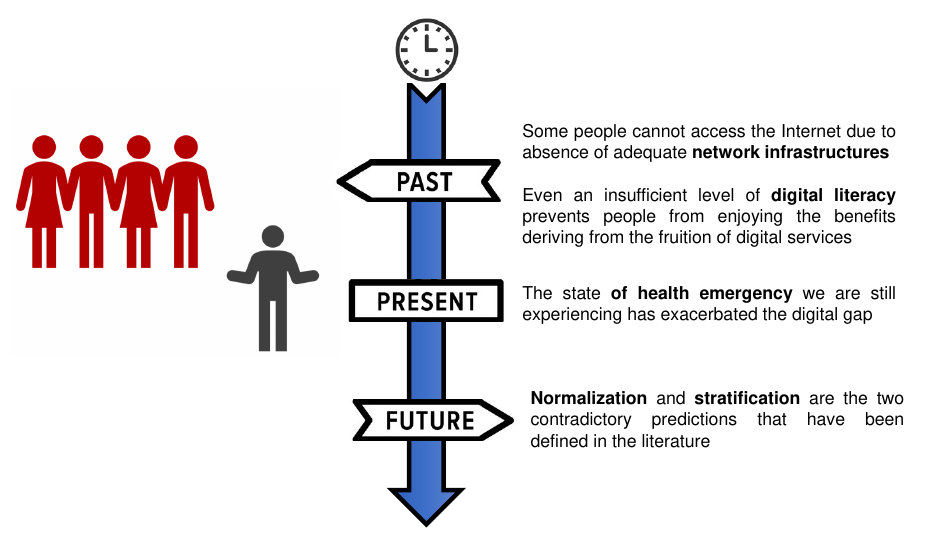
Figure 2. The evolution of the Digital